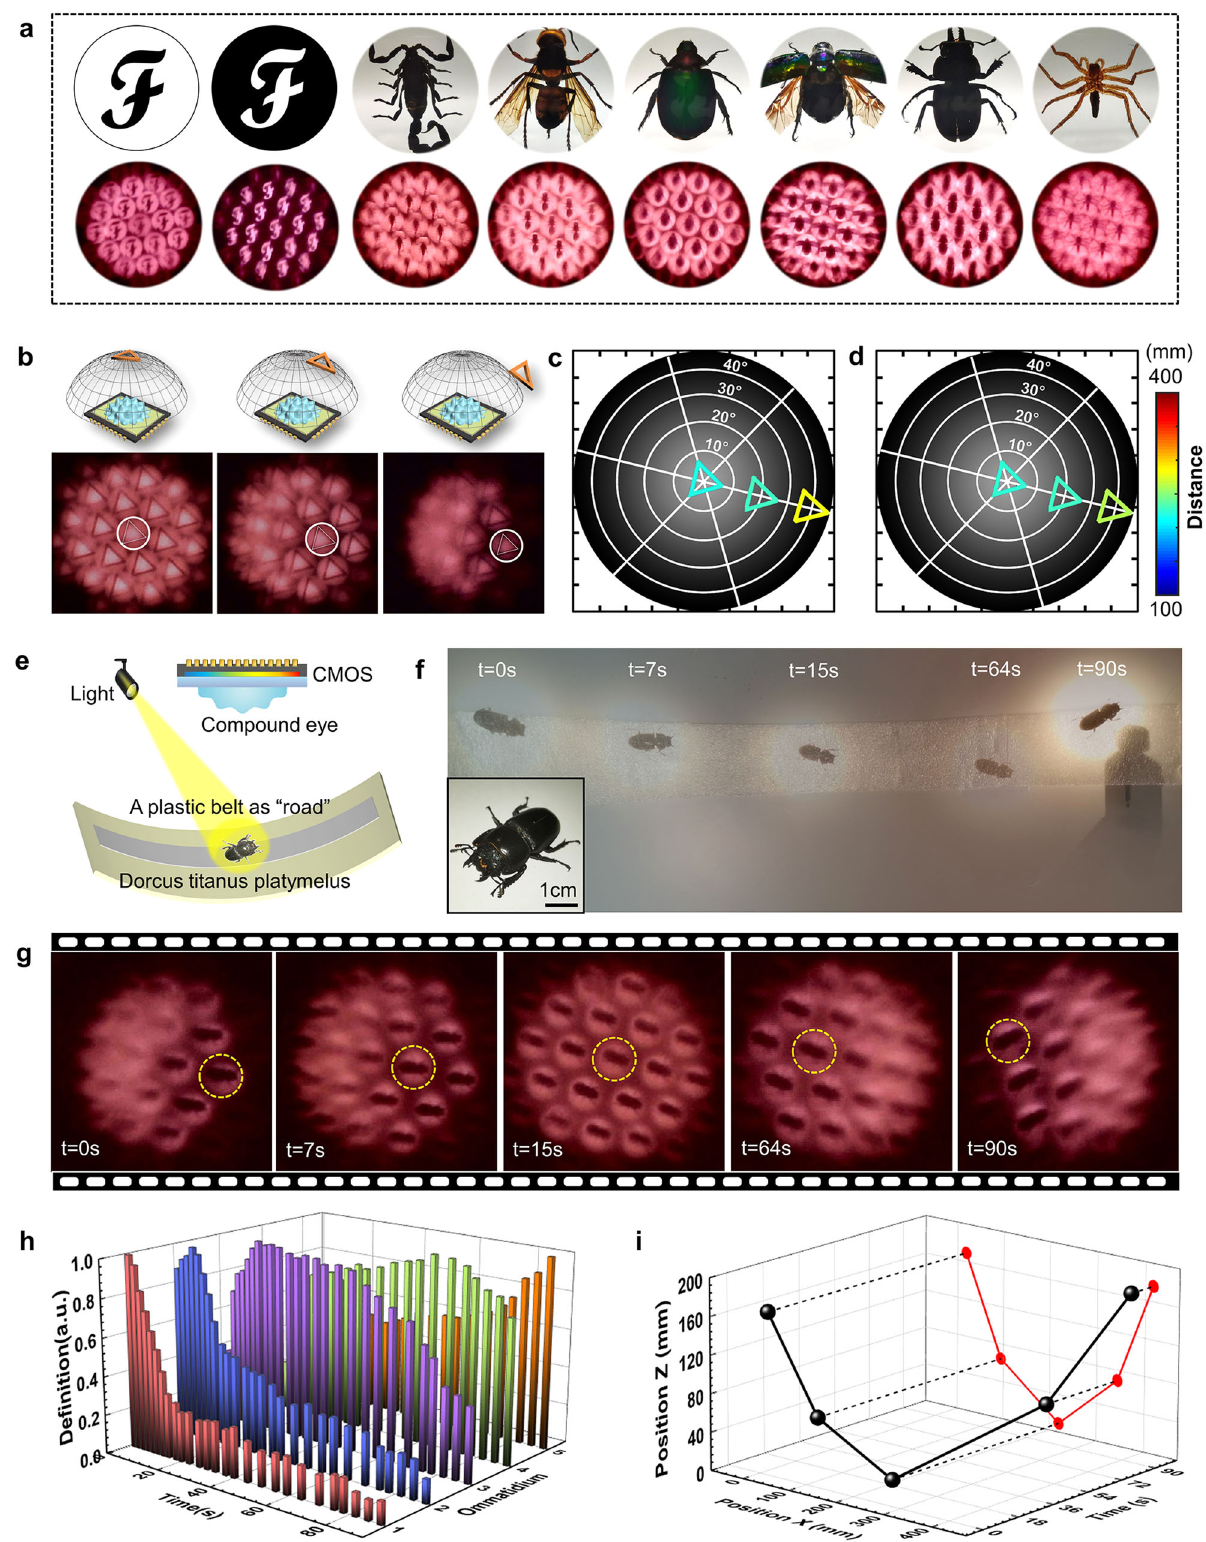
Fig. 4 | The imaging capability of the optoelectronic μ -CE camera. a Photographs of different targets (top) and the images collected by the μ -CE camera (bottom). b Schematic illustrations of the different spatial positions of a triangle model (top) and relative images captured by the μ -CE camera (bottom). c The true spatial position of the triangle relative to the μ -CE camera. d The cal- culated spatial position of the triangle according to the images; the side length of the triangular is known (20mm). The radius of the imaging FOV is 80mm. e Schematicdiagramoftheexperimentalsetupformonitoringbeetlemotionusing